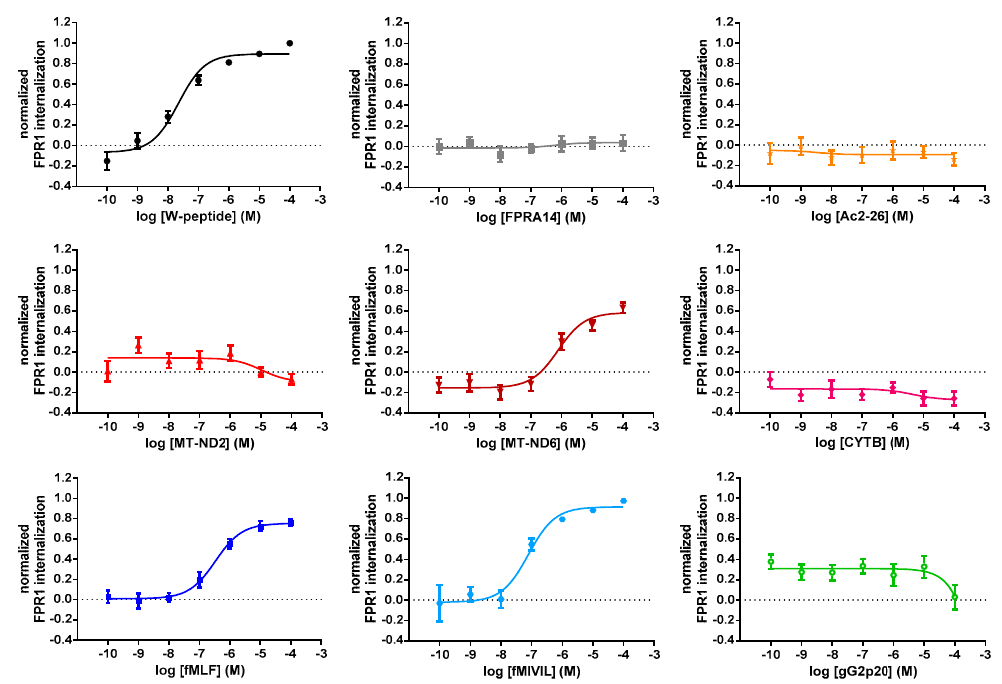
Figure 4. Concentration–response curves for agonist-induced FPR1 internalization. Receptor internalization was calculated as the difference between FLAG signals of unstimulated cells and signals recorded 15 min after agonist addition. Results were normalized to the maximum system response obtained with 10 − 4 M W-peptide. Data points represent the mean ± SEM of 6 independent measurements.